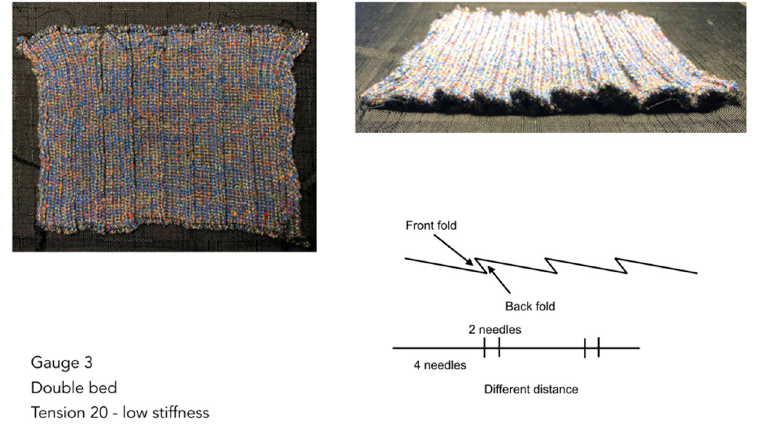
Figure 9. Sample 2. Low stiffness.